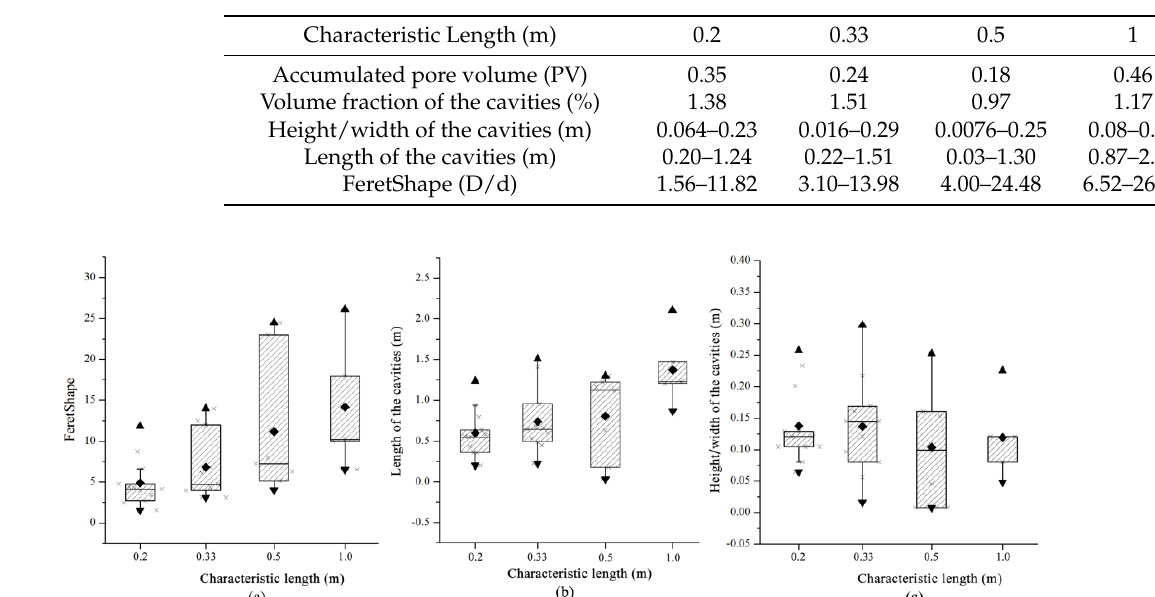
Figure 10. Comparison of the shape parameters for different characteristic lengths. ( a ), ( b ), and ( c ) represent the statistical results of FeretShape, length of cavities, height/width of cavities with different characteristic lengths, respectively.